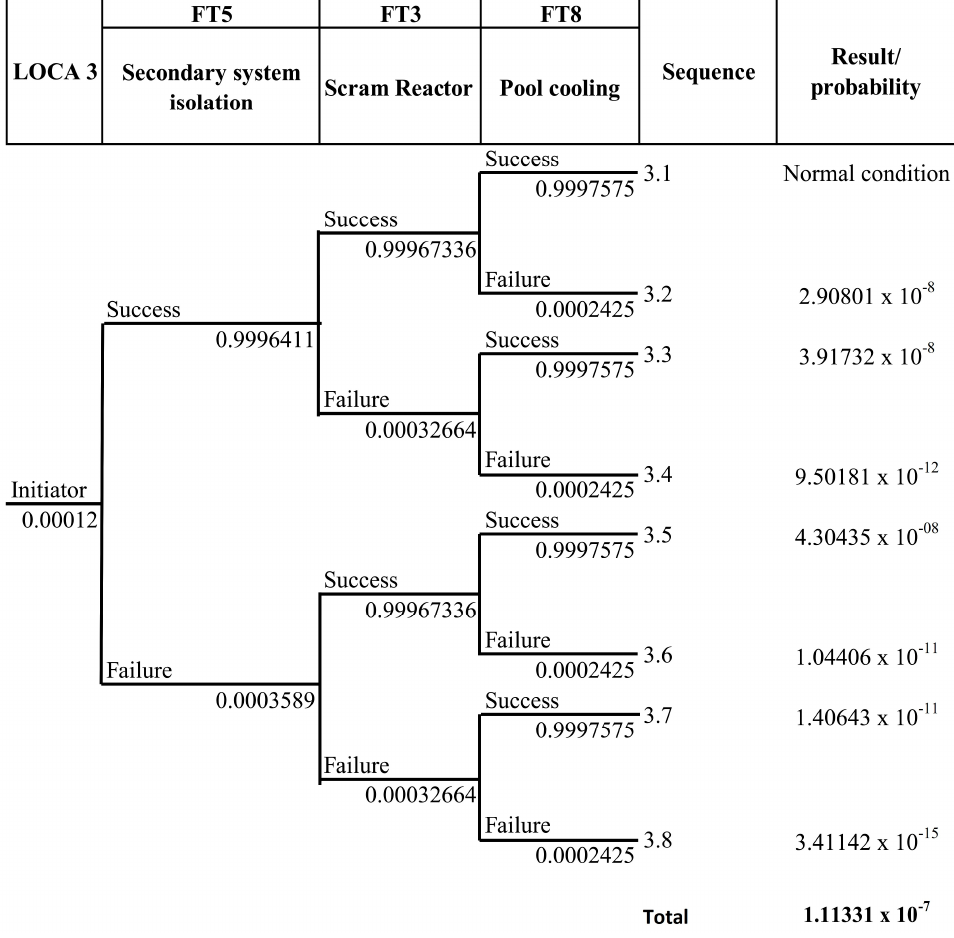
Figure 12. Event tree of LOCA 3.